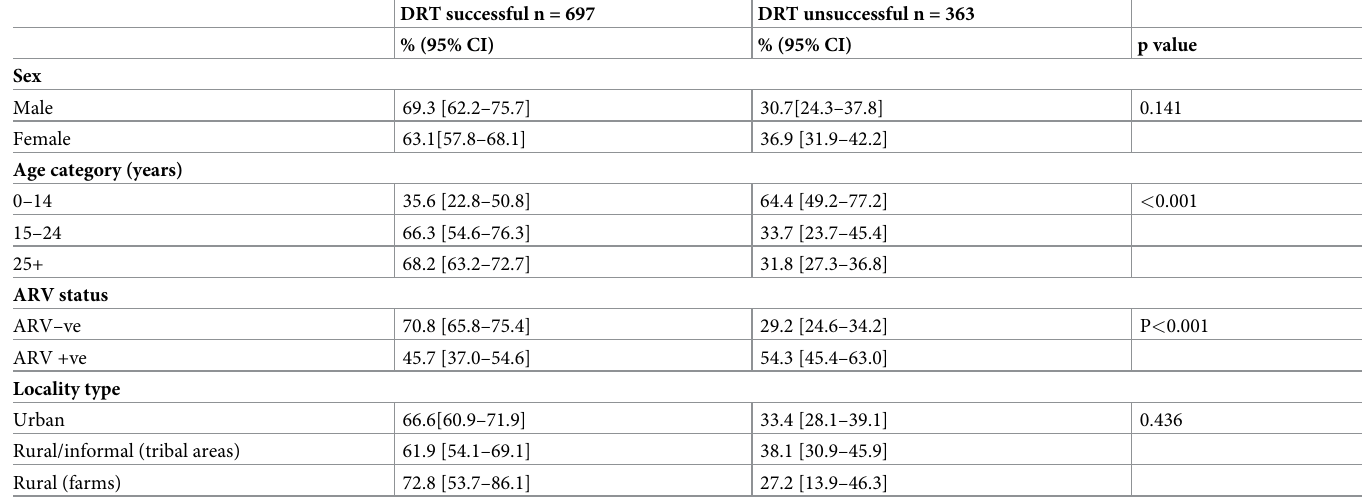
Table 1. Characteristics of respondents with samples that were successfully genotyped and those that were not.